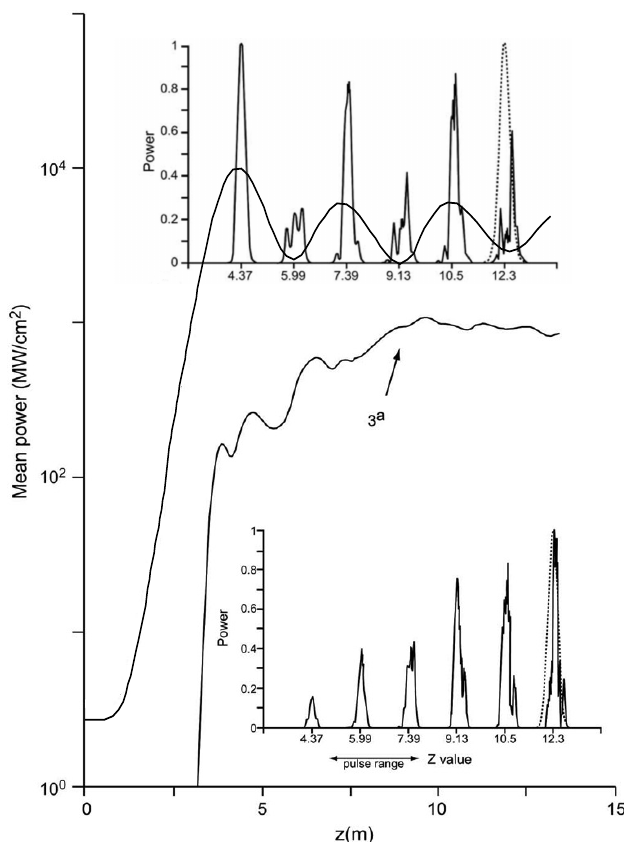
Figure 13. First and third harmonic power growth vs. z , along with the power oscillations and associated changes in the laser packet